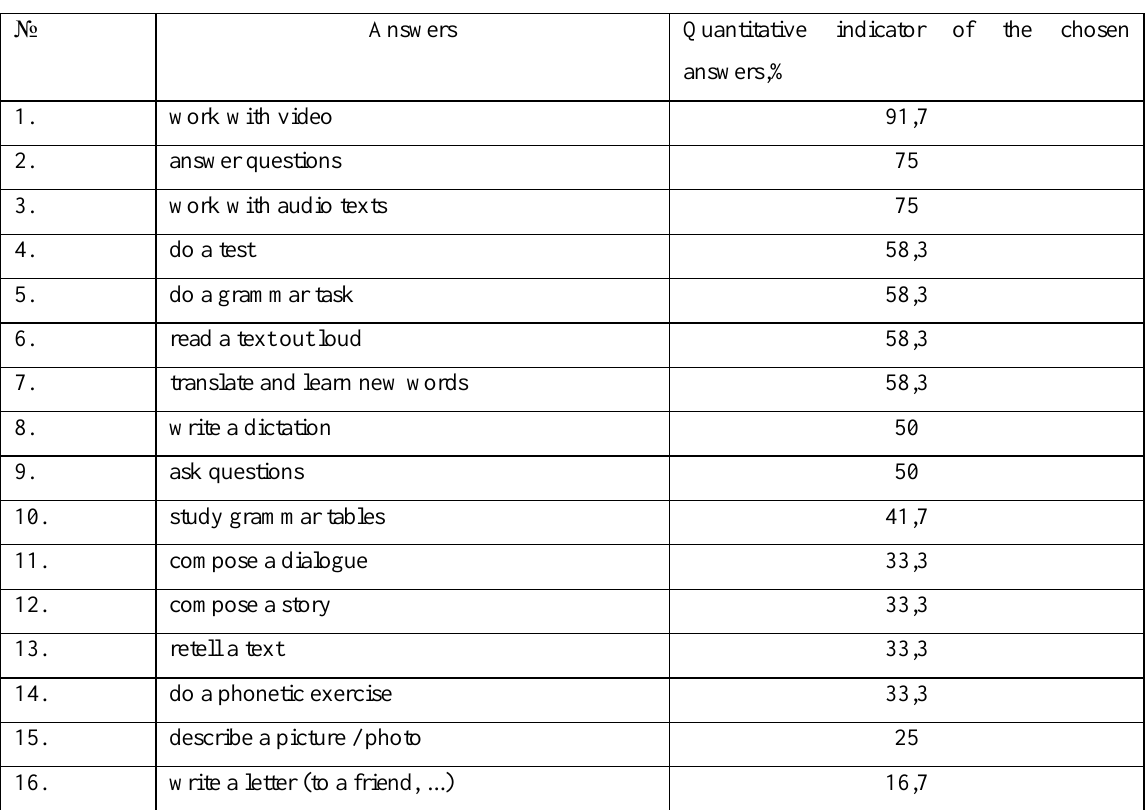
Table 1. Answers to the question “What tasks do you like to do?”